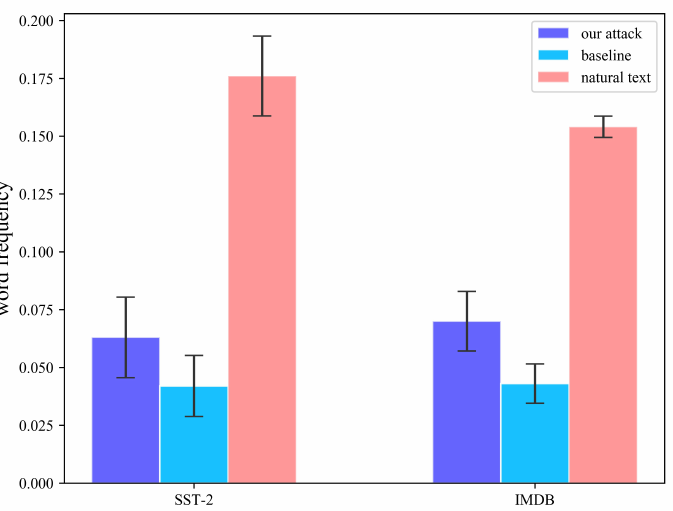
Figure 6. Word frequency. The average frequency and root mean squared error of different triggers in the target model training set